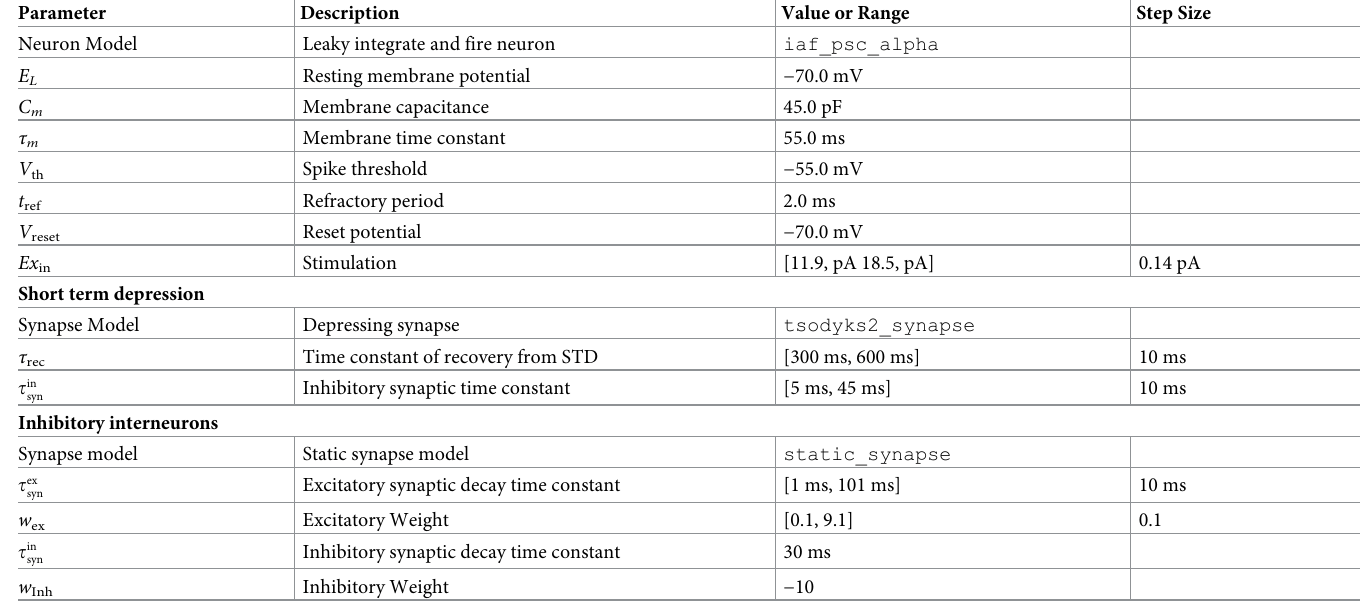
Table 1. This table lists all parameters of the neuron and synapse models as used in the specific simulations. The neuron parameters are common in all simulation. In case one parameter was varied in different simulations a range and step size are given. If parameter was constant in all simulations only its value is given.